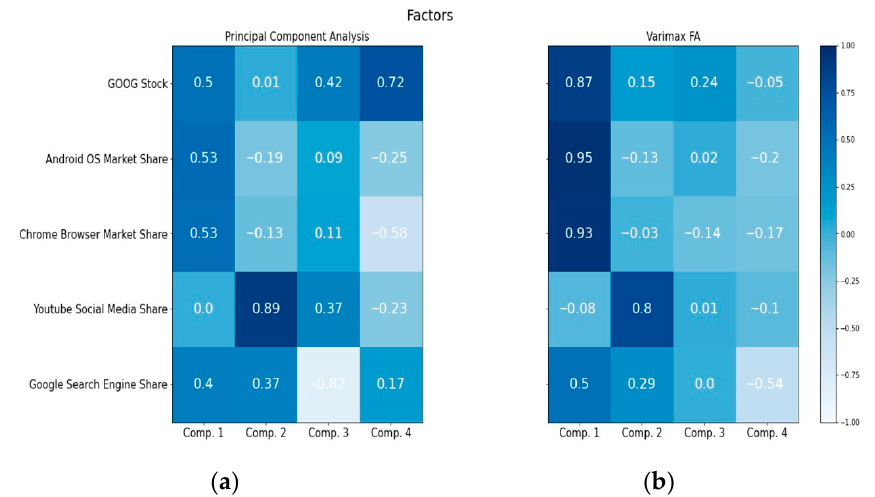
Figure 6. Factor analysis: ( a ) Principal component analysis factors; ( b ) Varimax Fa factors.